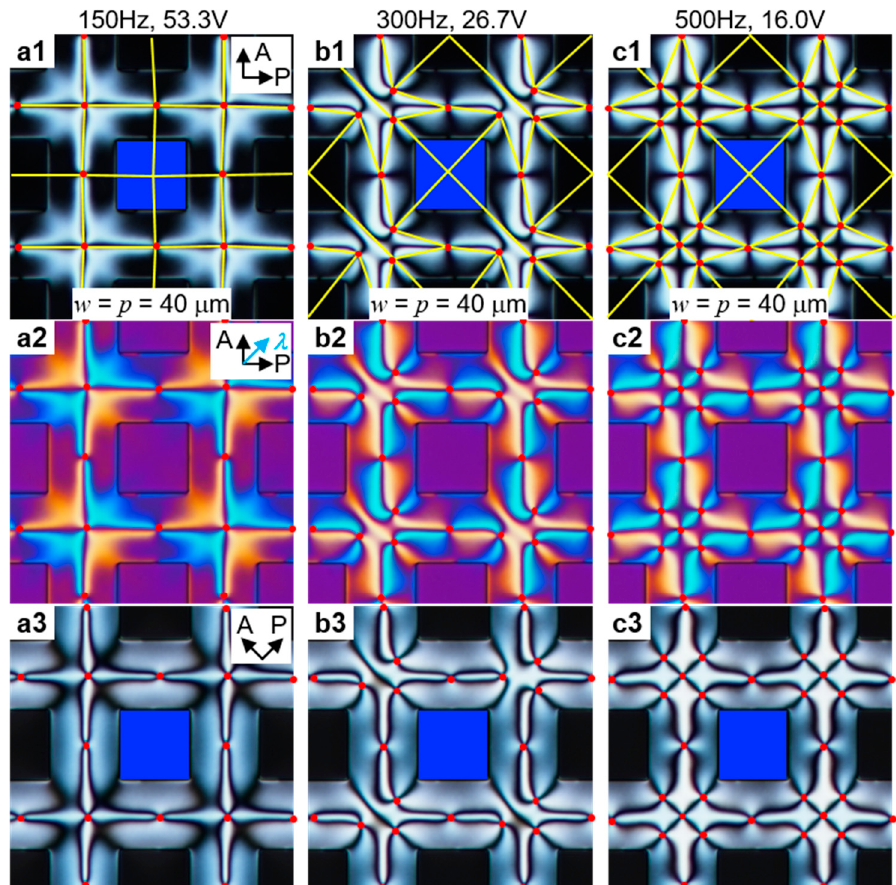
Figure 6. Defect array formation and transition in square-shaped pillars of w = p = 40 μ m observed by polarizing optical microscopy: ( a ) f = 150 Hz, V = 53.3 V; ( b ) f = 300 Hz, V = 26.70 V; and ( c ) f = 500 Hz, V = 16.0 V. ( a1–c1 ) Under crossed polarizers in the orthogonal direction; ( a2–c2 ) with a full-wave plate; and ( a3–c3 ) at 45 degrees, as indicated in the inset. Pillar height is h = 2 μ m and cell thickness is d = 5.6 μ m. P, polarizer; A, analyzer; λ , full-wave plate. The red dots are umbilical defects; the blue square is the central pillar; and the yellow lines indicate the lattice at 0 or 45 degrees and are a guide for the eye.